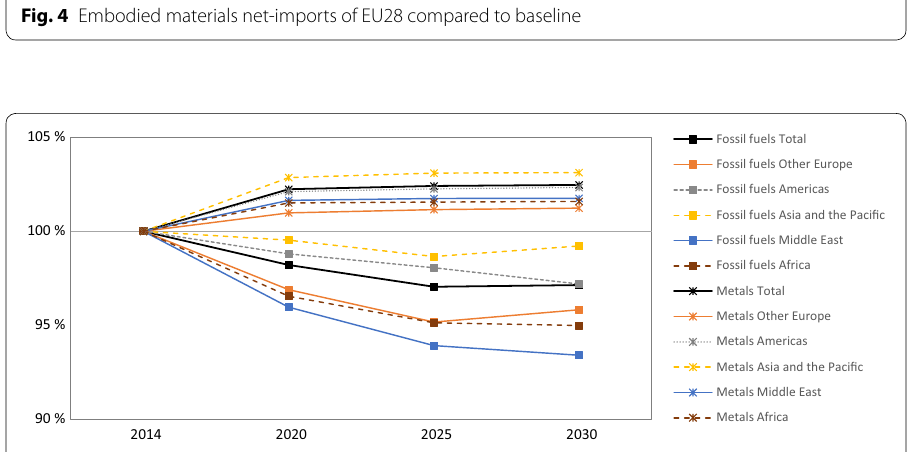
Fig. 5 EU28 imports of embodied materials for EU28